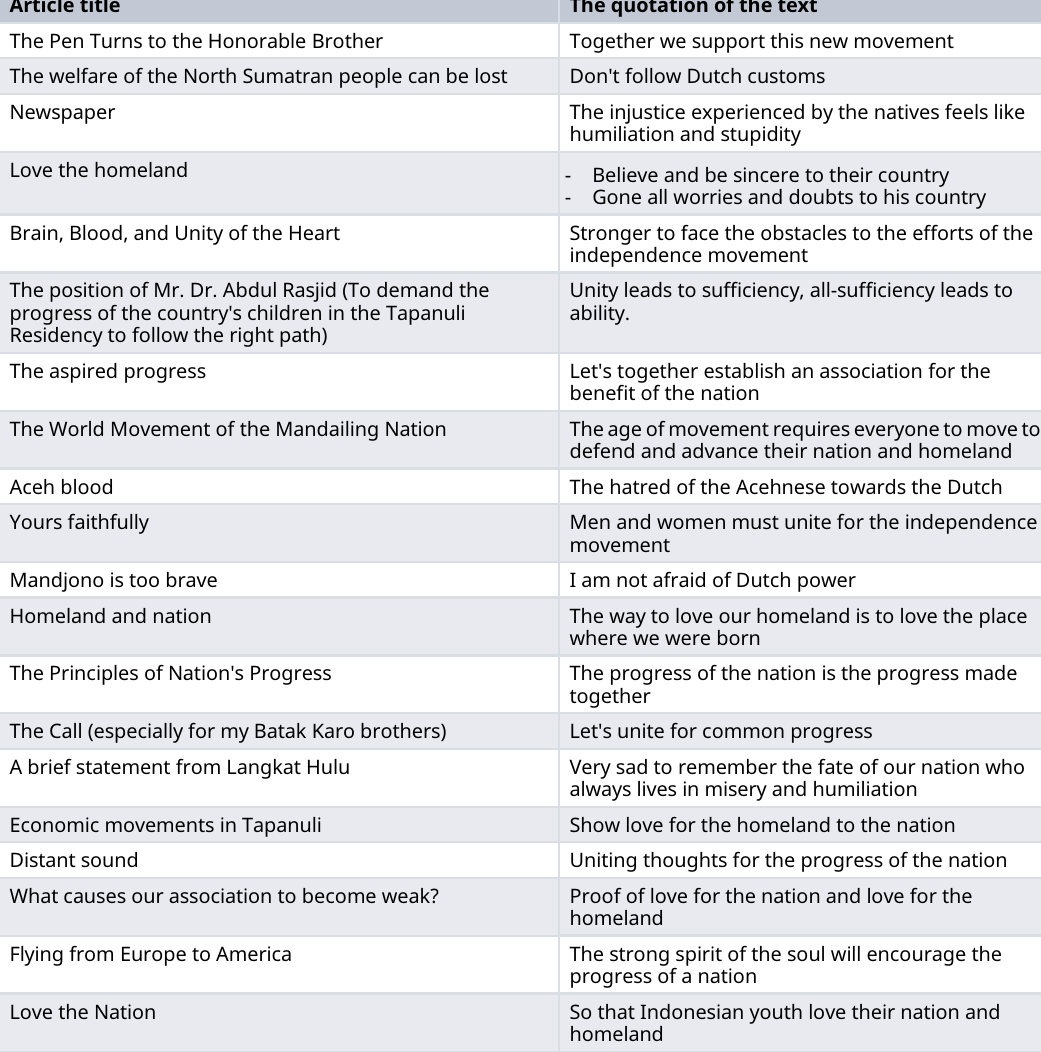
Table9.Theresultsofthemicrostructuralanalysisfromthenewspapersthatspreadthespiritofnationalism, unity, and the Indonesian independence